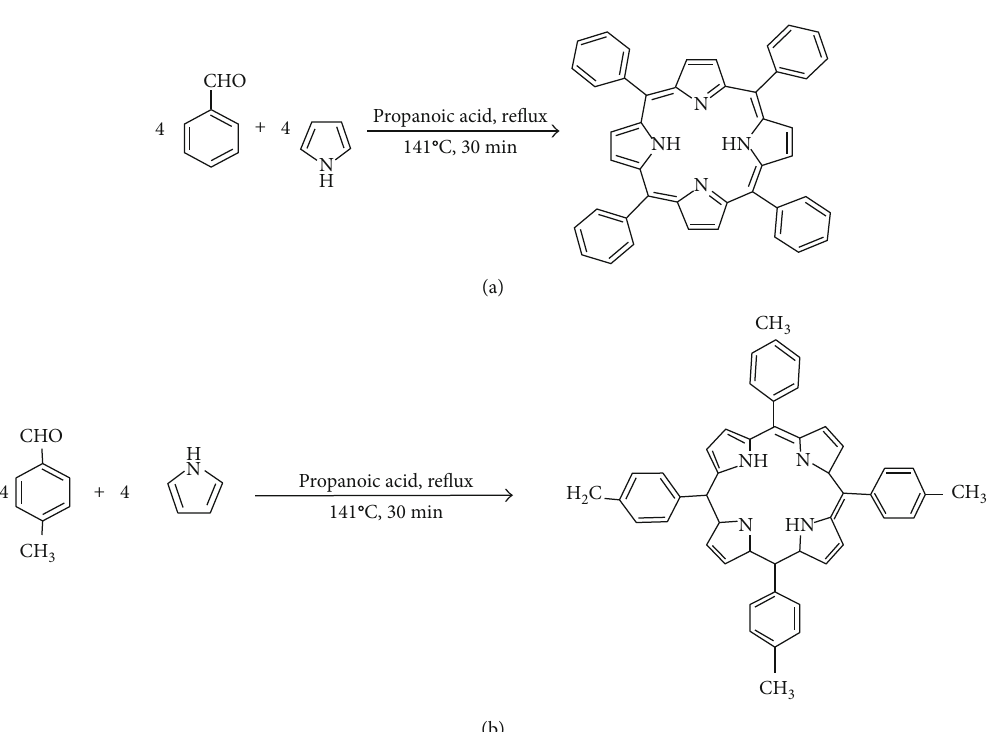
Figure 2: Synthesis methods of the 5,10,15,20-tetraphenylporphyrin (H (H TTPP). 2